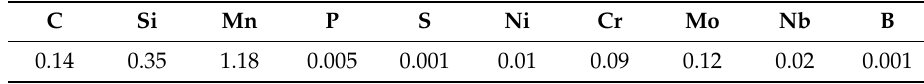
Table 1. Chemical composition of HT780 (mass %).